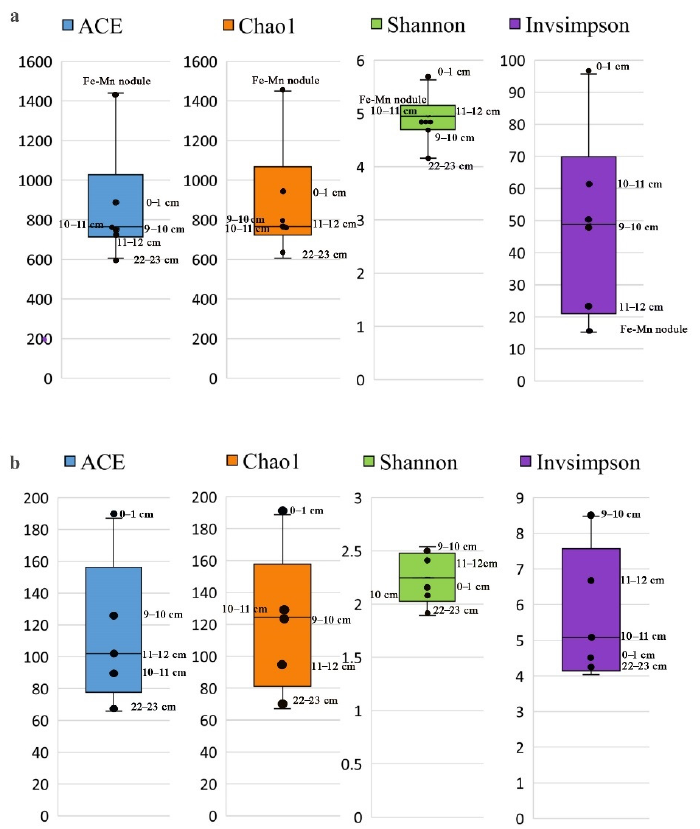
Figure 5. Box plots show ( a ) bacterial and ( b ) archaeal alpha diversity (ACE and Chao1